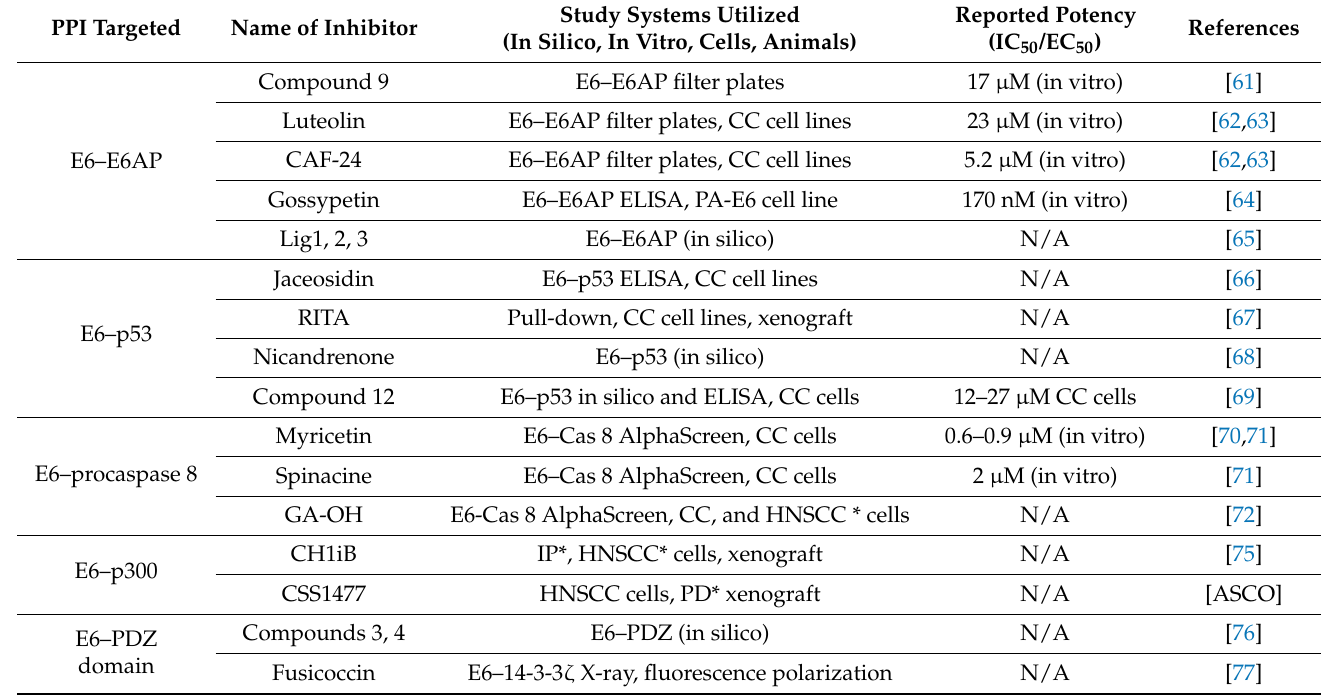
Table 1. Summary of compounds tested for their ability to inhibit E6